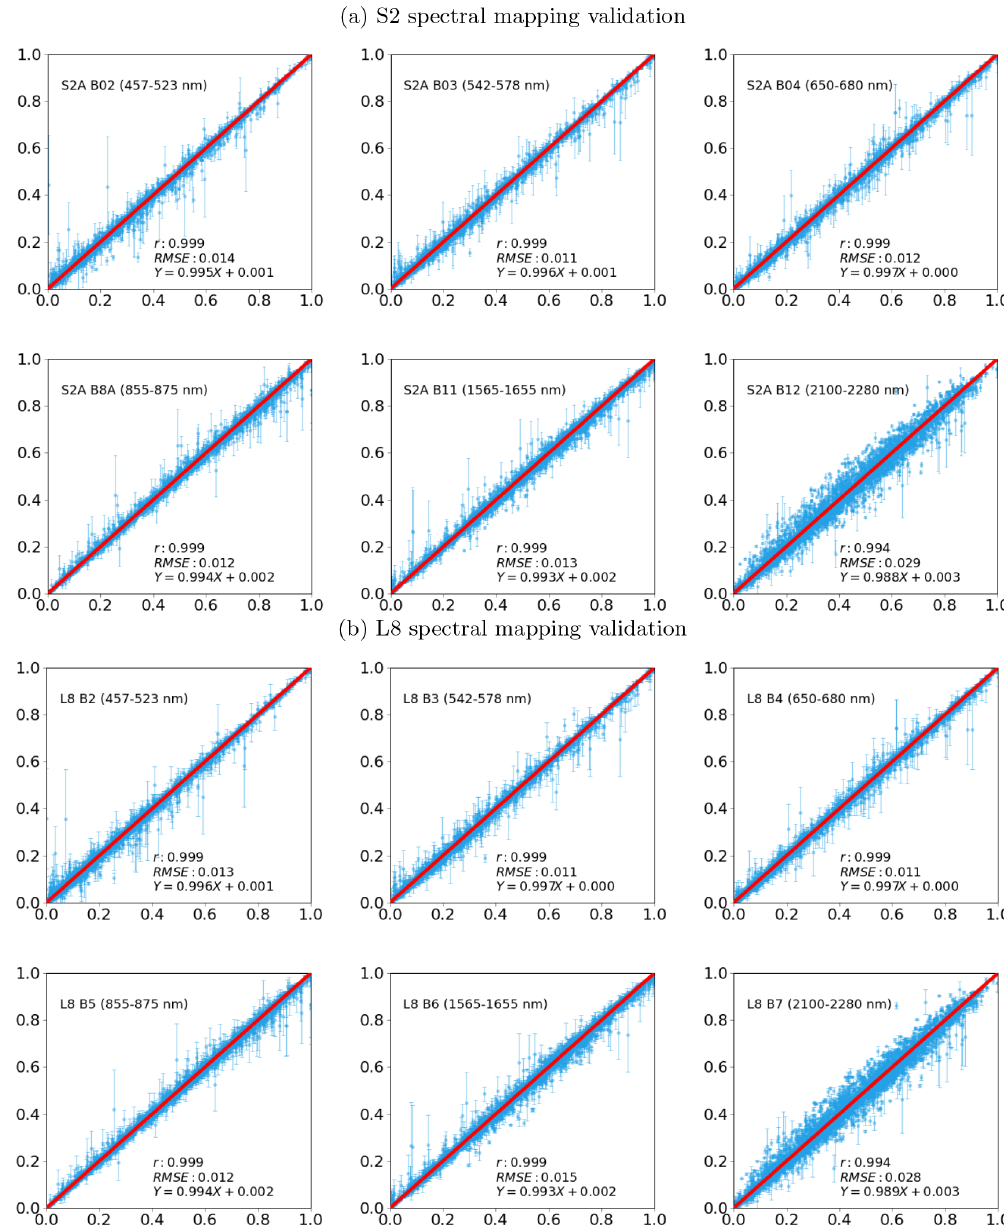
Figure D2. S2 (a) and L8 (b) reflectance predicted by MODIS Aqua-selected spectra from the spectral library. The uncertainty is shown with 1 σ range. The original values are from the direct simulated reflectance by applying S2 and L8 RSR to the individual spectrum in the spectra